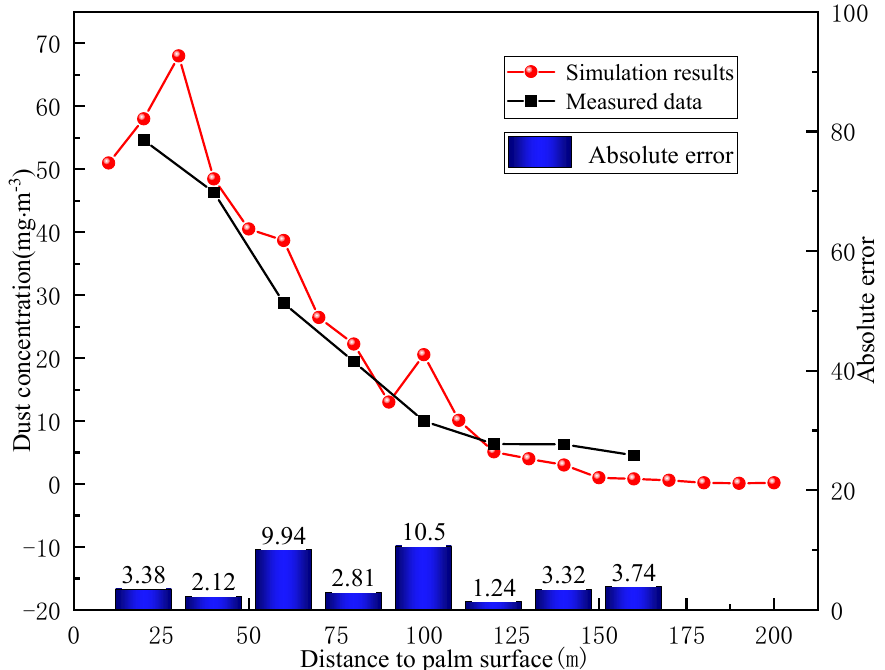
Figure 9. Comparison between the simulated and measured values of the dust concentration.